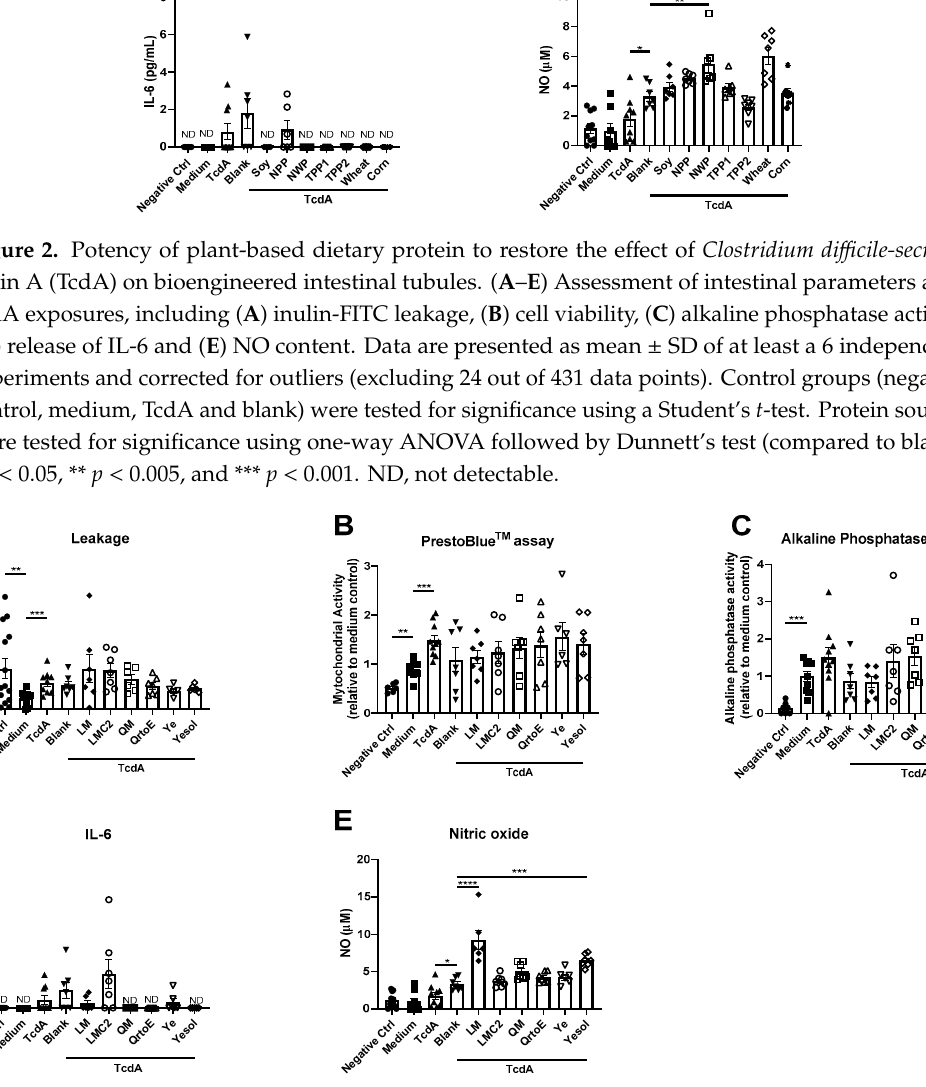
Figure 3. Potency of alternative-based dietary protein to restore the e ff ect of Clostridium di ffi cile-secreted